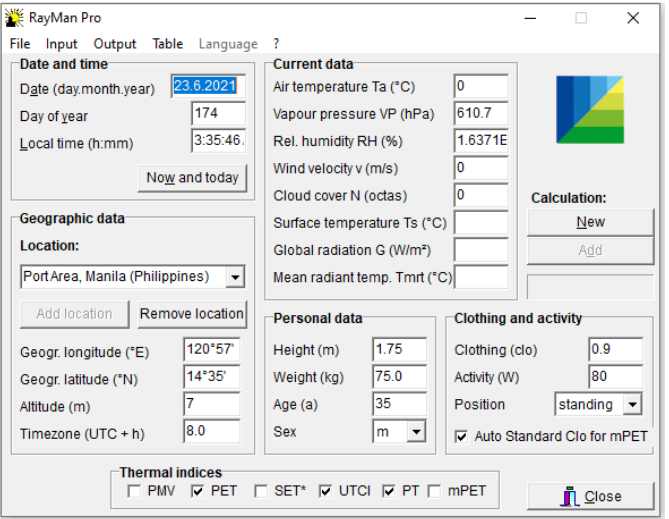
Figure 3. RayMan Pro Graphical User Interface. Geographic data, personal data, and clothing and activity information are shown.